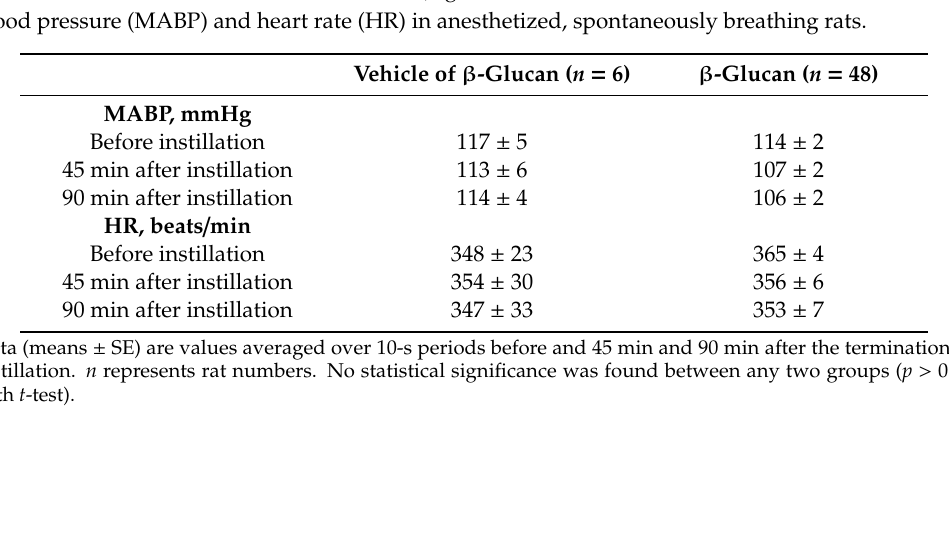
Table 2. E ff ects of intratracheal instillation of β -glucan and its vehicle on the baseline of mean